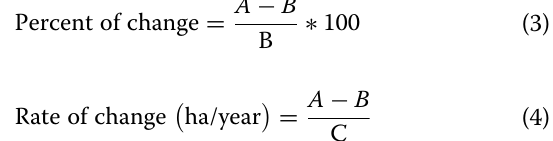
Table 3 A 7 7 LULC transition matrix for comparing two maps from different points in time. Source: Modified from × Pontius et al. (2004), Braimoh (2006), Amare (2007), Adugna et al. (2017)